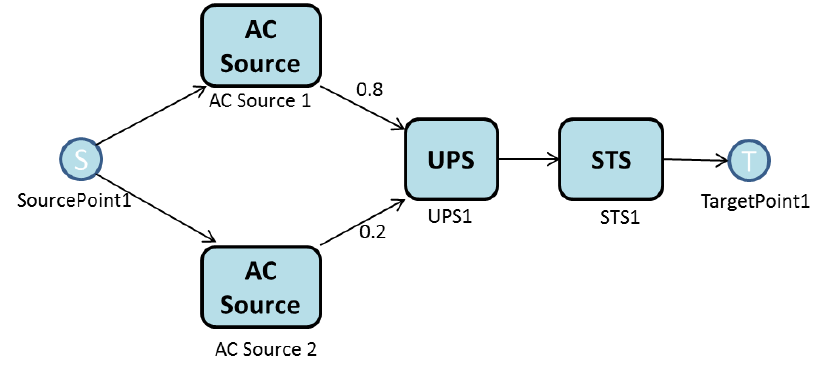
Figure 4. A simple example of energy modeling with the Energy Flow Model